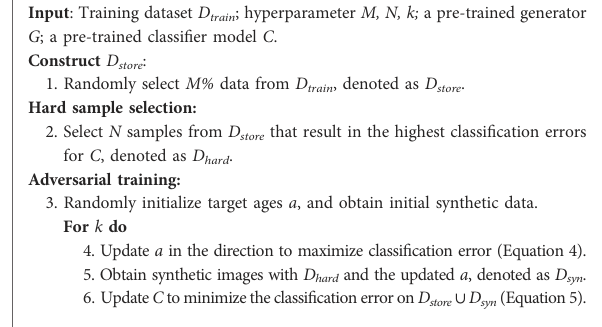
Algorithm 2: Adversarial classi fi cation learning with D store